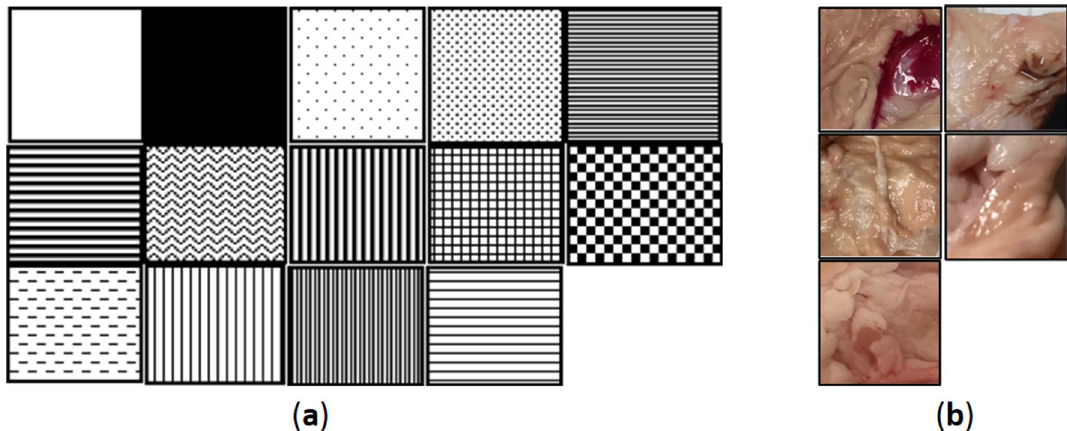
Figure 7. ( a ) Basic patterns, ( b ) WCE-like colored